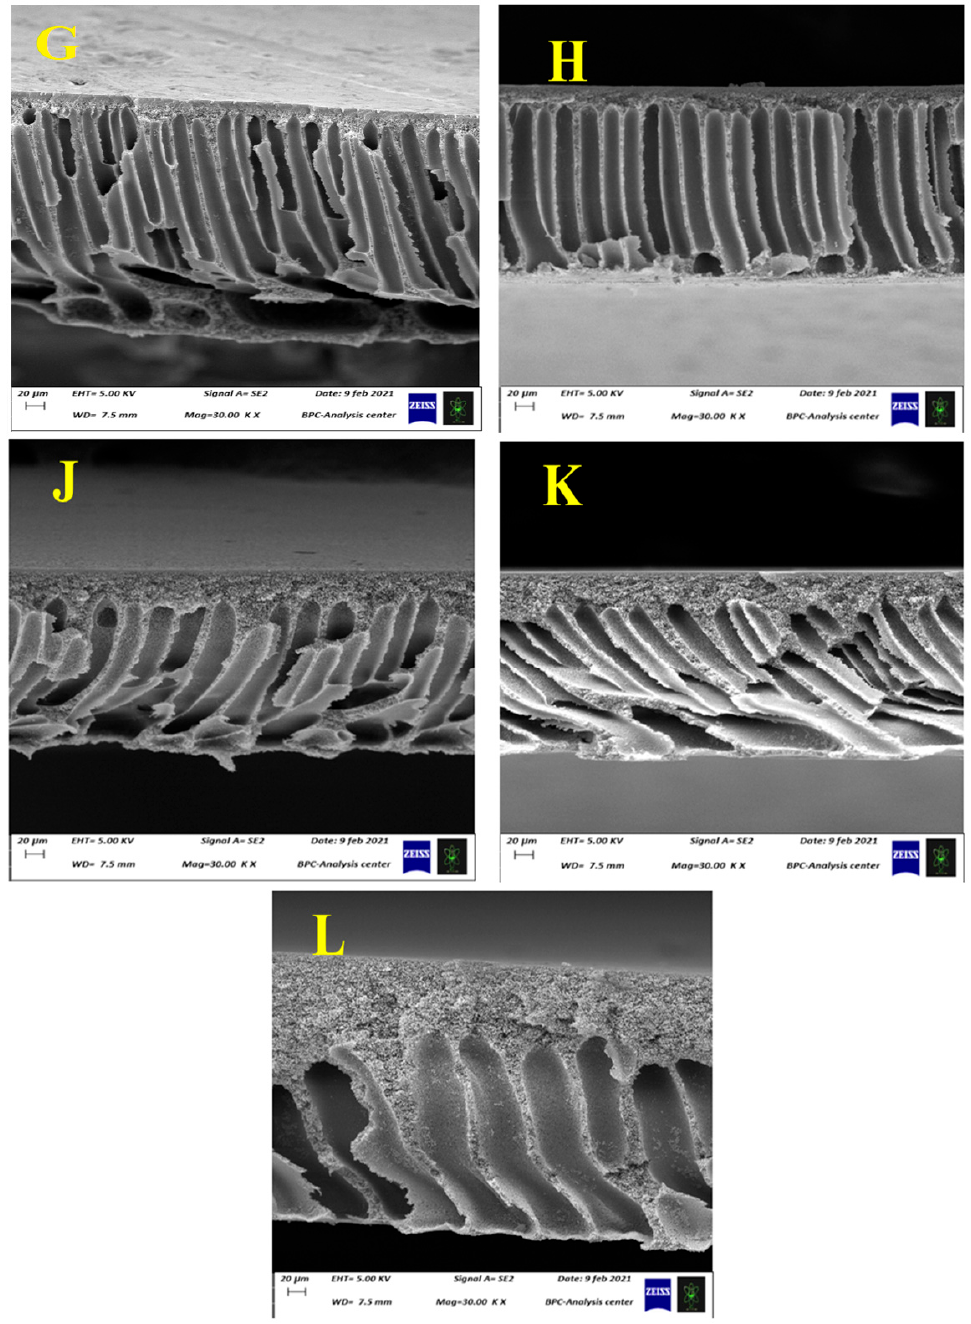
Figure 6. SEM cross-section images for ( A ) pristine, ( B ) 0.25 g, ( C ) 0.5, ( D ) 0.75 g, ( E ) 1 g, ( F ) 1.25 g, ( G ) 1.5 g, ( H )1.75 g, ( J ) 2 g, ( K ) 2.25 g, and ( L ) 2.5 g PMG-modified membranes. Surface topography parameters of the pristine and PMG NPs modified membranes have been determined via AFM. The 0.8 µ m × 0.8 µ m three-dimensional images of the eleven membrane samples are depicted in Figure 7A–L. In the presented images, regions with a dark colour referred to the lowest points, while the regions with a bright colour referred to the peaks. As can be seen in Figure 7A and Table 3, the neat PES membrane revealed the flattest surface compared to other nanocomposite membranes. The arithmetic mean height (Ra), root-mean-square height (Rms), and maximum height (Rz) were found to be 3.55, 6.3, and 24, respectively. Unsurprisingly, these smooth features of the PES membrane were expected since these are the inherent roughness characteristics of the